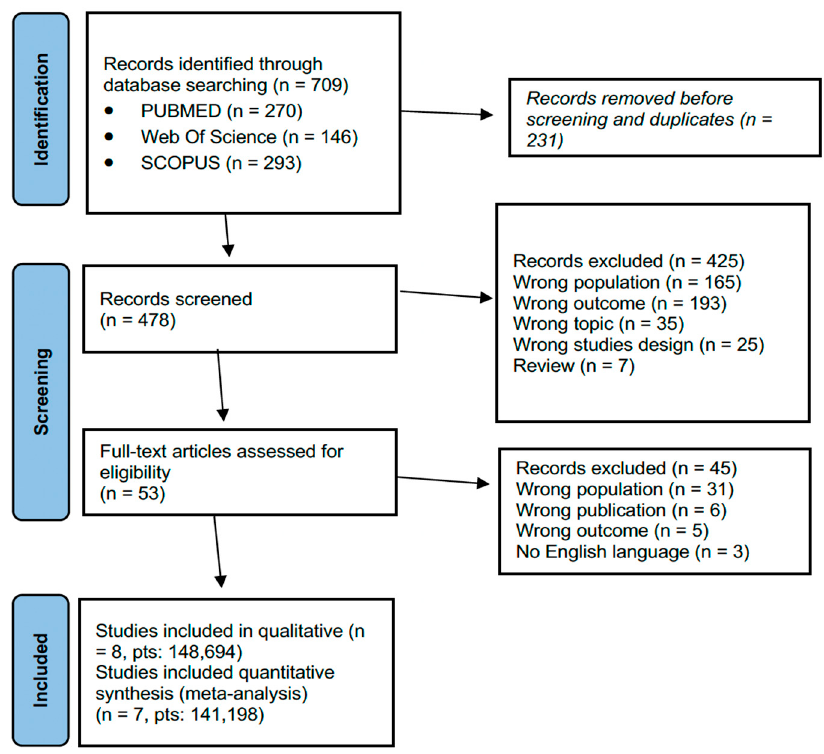
Figure 1. PRISMA flowchart for study selection. Table 1. Main characteristic of the included studies.